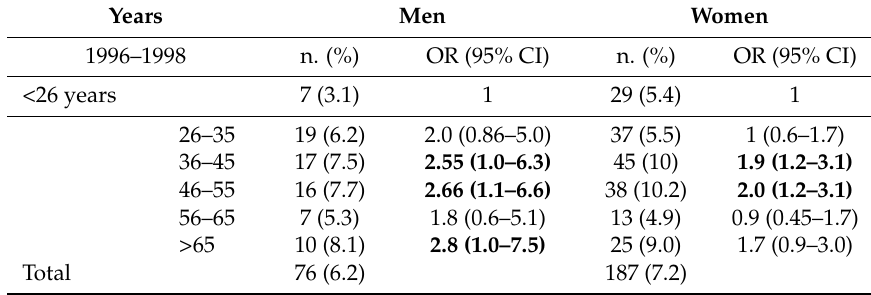
Table 2. Sensitization to fragrance mix-1 in different age groups and years evaluated using the logistic regression analysis. Results are reported as Odds Ratios (OR) and Confidence Intervals (95% CI).